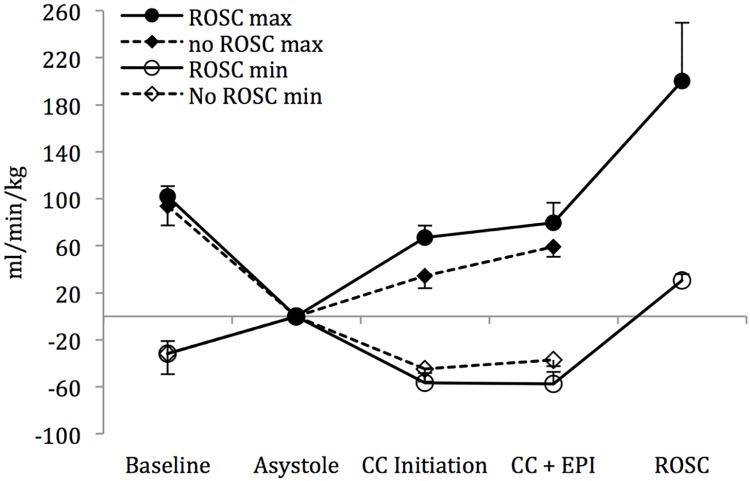
Left pulmonary artery flow.Maximum flow increases with initiation of chest compressions in lambs with ROSC and no ROSC. Reversal of flow occurs in diastole (minimum flow) at baseline (in utero), and remains retrograde during the relaxation phase of chest compressions in lambs of both groups. Flow becomes exclusively anterograde upon ROSC and cessation of chest compressions. Data are mean ± SEM bars.